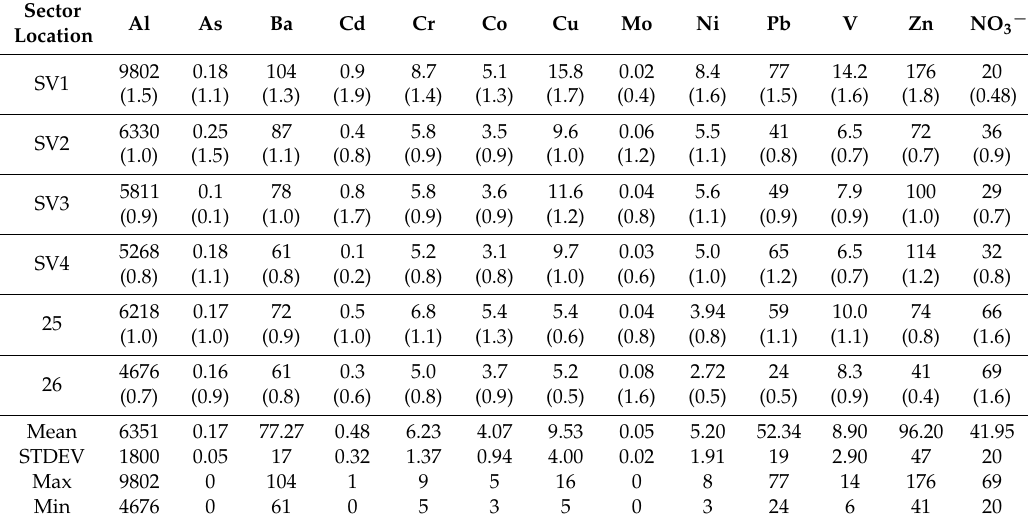
Table 2. Summary statistics for metal and NO 3 − concentrations from 6 background collection